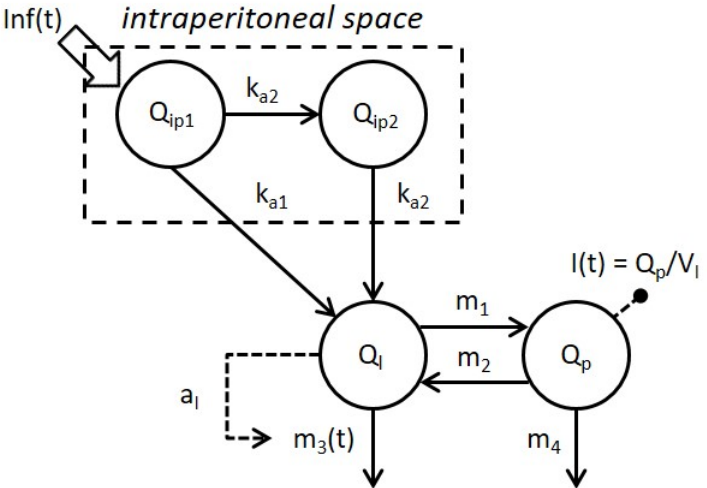
Figure 2. Schematic representation of the selected model combining Model 3 of intraperitoneal absorption of insulin and Model C of whole-body insulin kinetics. Model compartments are repre- sented by white circles, fluxes and control signals are indicated by continuous and dashed arrows respectively. Signals Inf(t) and I(t) represent the intraperitoneal insulin administration and plasma insulin concentration, respectively.